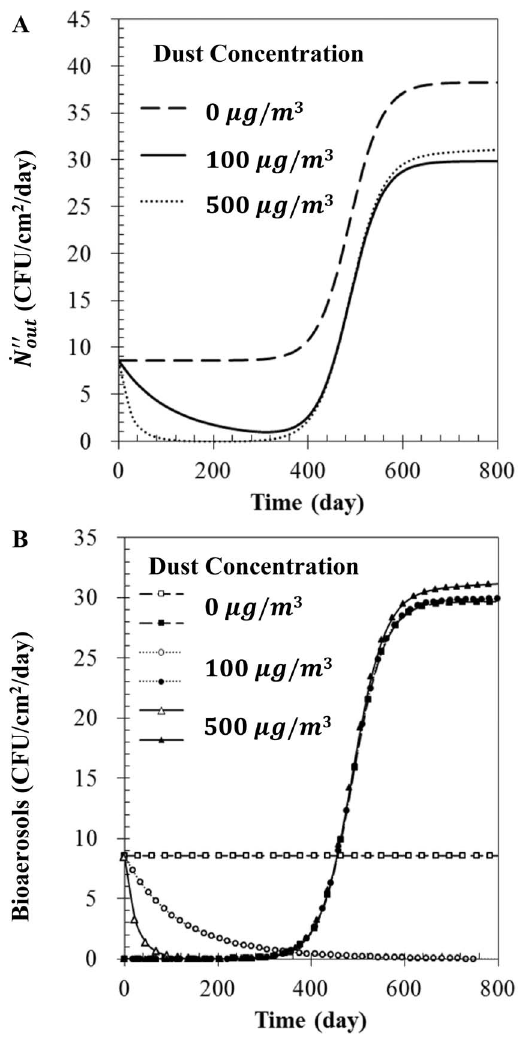
(filled symbol) for Filter 2 entrain